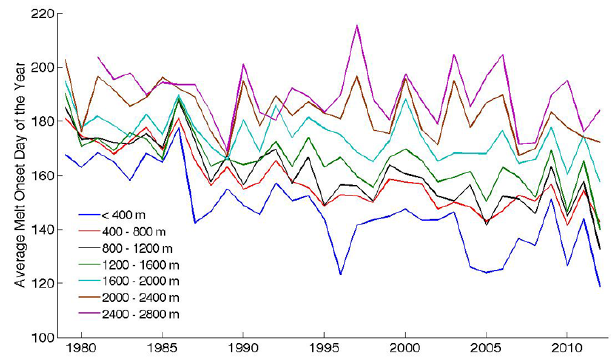
Fig. 3. Average melt onset date (day of year) by elevation bands from passive microwave data using the algorithm in Mote and An- derson (1995).